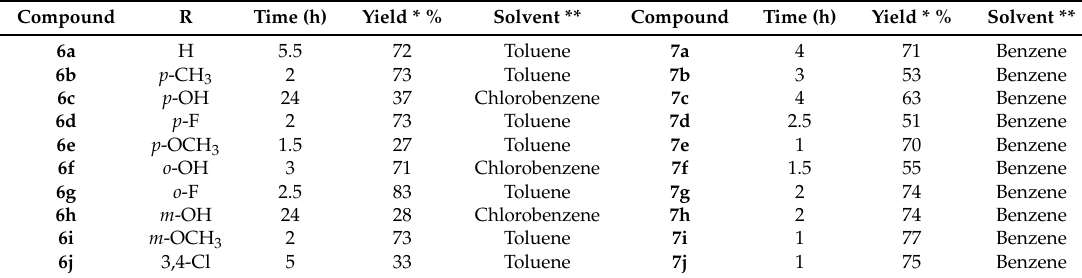
Table 1 . Data for the synthesis of benzoxazoles and their precursors 78 *: The yield was calculated after purification by crystallization or column chromatography. 79